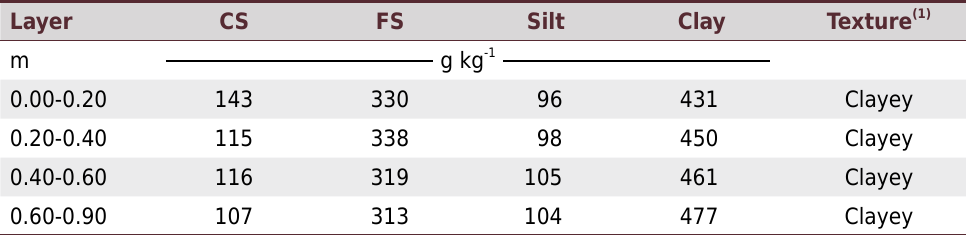
Table 2. Soil physical characterization from the 0 to 0.9 m soil